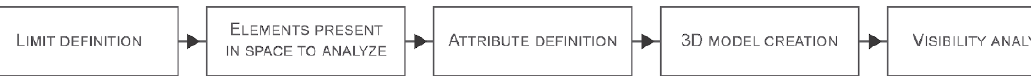
Figure 1. Research method diagram.